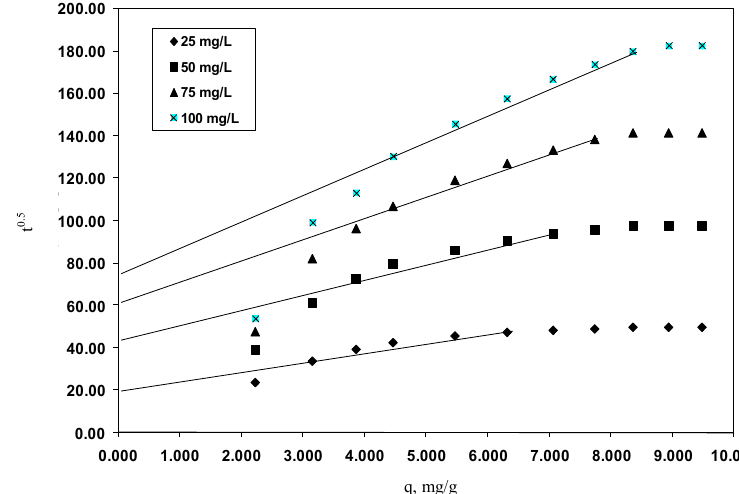
Figure 10. Intra particle diffusion for the adsorption AG 25 on to ACC at 303